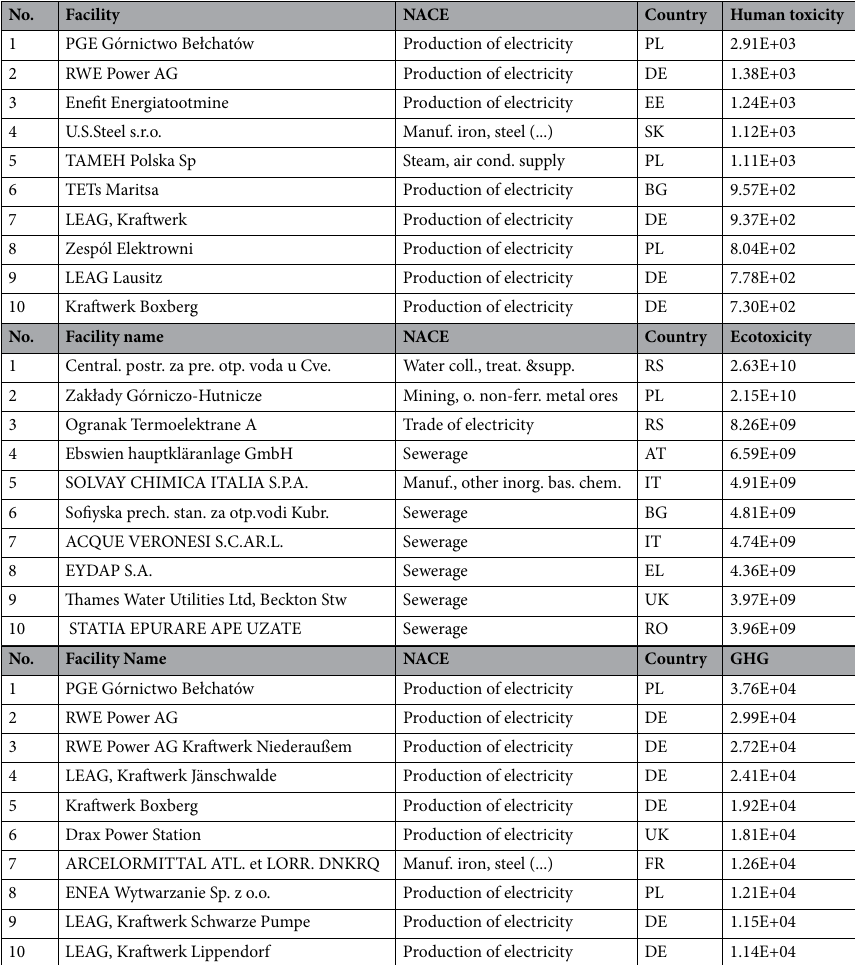
Table 4. The facilities with the largest contribution to human toxicity (CTUh), ecotoxicity (CTUe) and global warming potential (CO2eq Kt), emitted from E-PRTR point sources to air and water in 2017, characterized with USEtox 2.12 and IPCC global warming potential values. Only the 10 facilities with the largest impact potentials are shown. Assumptions made in toxicity characterisation are given in the Methods section, and follow Sörme et al. (2016). Calculations were based on the sub-compartment level for toxicity. This table shows the aggregated toxicity and global warming impact potentials by the most polluting facilities. The emissions in kilograms ( E ijk ) of substances (i) in the EPRTR have been multiplied by their USEtox 2.12 toxicity characterisation factors ( CF ijk ), by the global warming potential value ( GWP i ) and aggregated across all substances, release media (j) and release sub-media (k). GWP values by greenhouse-gases reported under EPRTR are Methane (CH4): 25 co2eq, Carbon dioxide (CO2): 1co2eq, Hydro-fluorocarbons (HFCs):